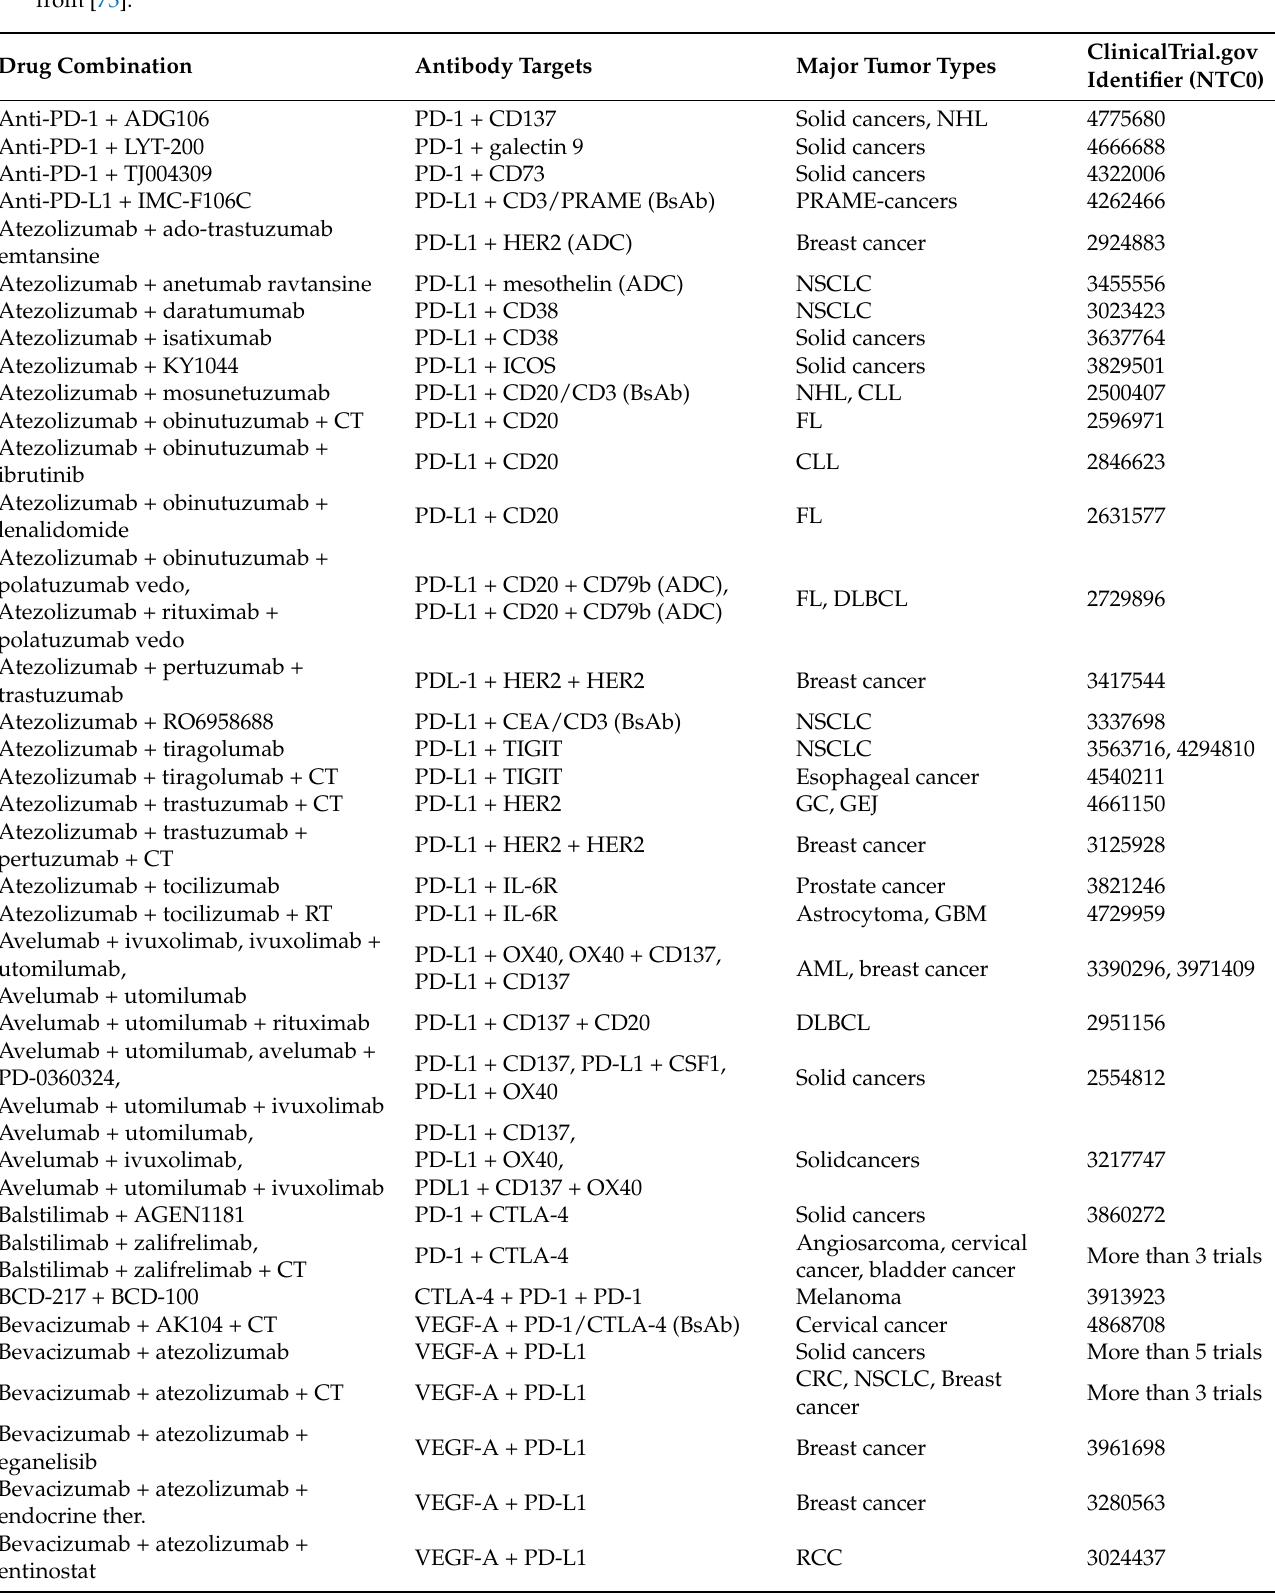
Table 1. Antibody-based drug combinations currently examined by clinical trials at the date of 3 May 2021, updated from